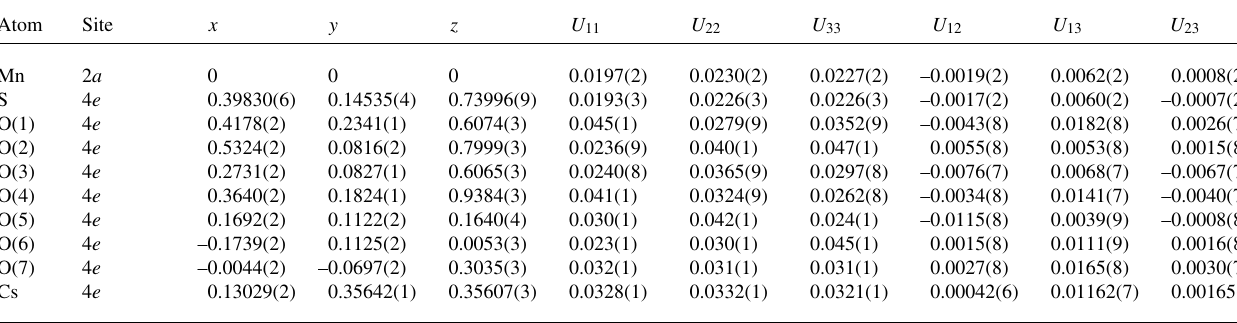
Table 6. Atomic coordinates and displacement parameters (in Å 2 )